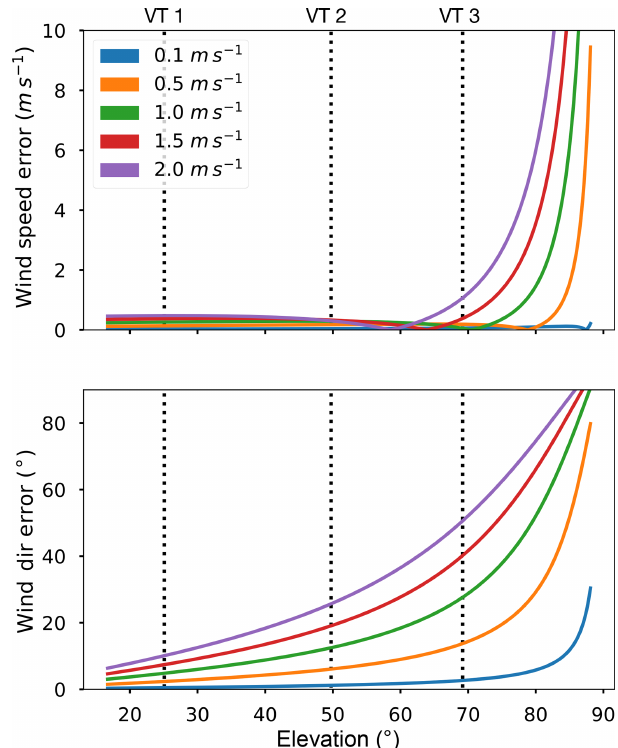
Figure 4. Wind speed and direction errors associated with ne- glecting the vertical velocity in 2D virtual towers. Results are for R = 300m and H = 200 as depicted in Fig. 3. These values were chosen to mimic virtual-tower measurements slightly above ridge height. The line colors correspond to different vertical velocities examined. The vertical lines correspond to the elevation for VT1, VT2, and VT3 for the given R and H ; thus these are the expected error for this point in space for these VTs. Note that as vertical ve- locity increases, error in wind direction estimation increases even at relatively low elevation